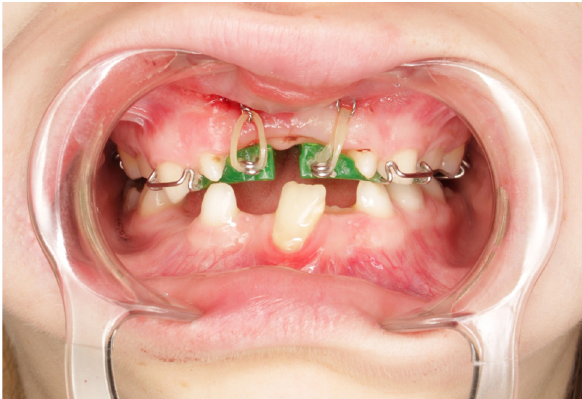
Figure 3. X-ray of the patient’s mouth.